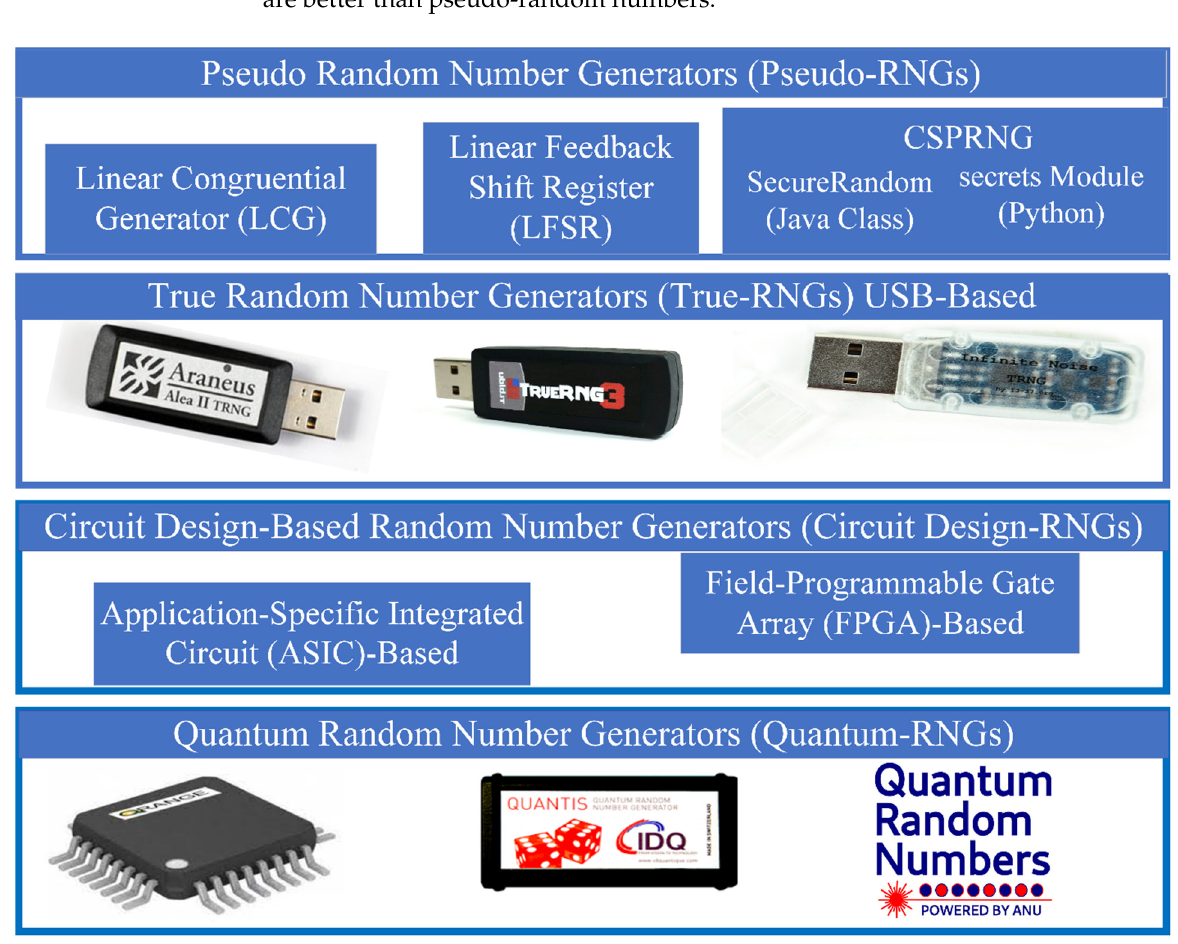
Figure 5. Categorization of random number generators: Implementation with applications.